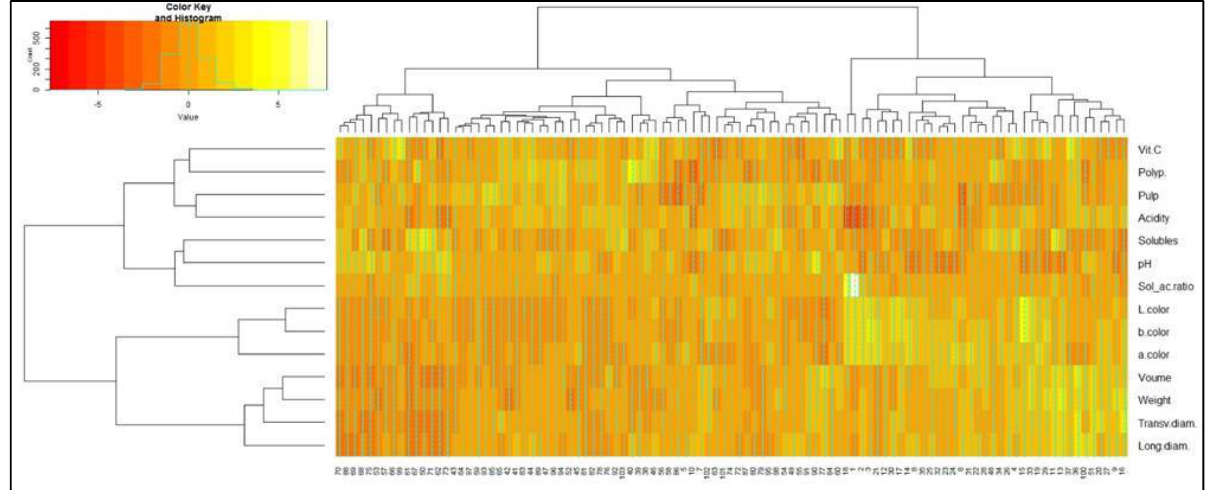
Figure 6. Dendrogram of variables obtained through cluster analysis (Ward’s method) representing the Euclidean distances of the 103 acerola phenotypes.